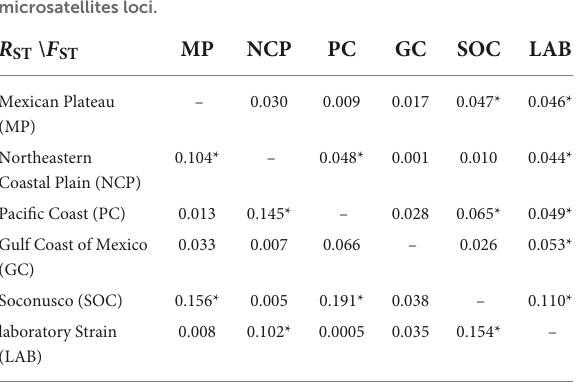
TABLE 2 Pairwise comparison R ST and F ST in nDNA microsatellites